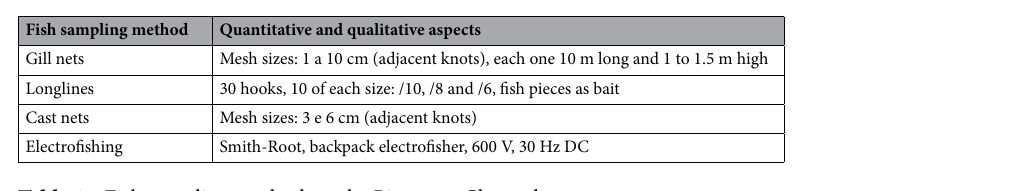
Table 1. Fish sampling methods at the Piracema